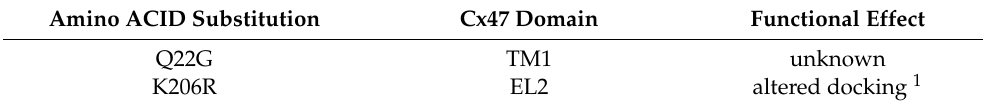
Table 2. Overview of GJA1 gene mutations associated with secondary